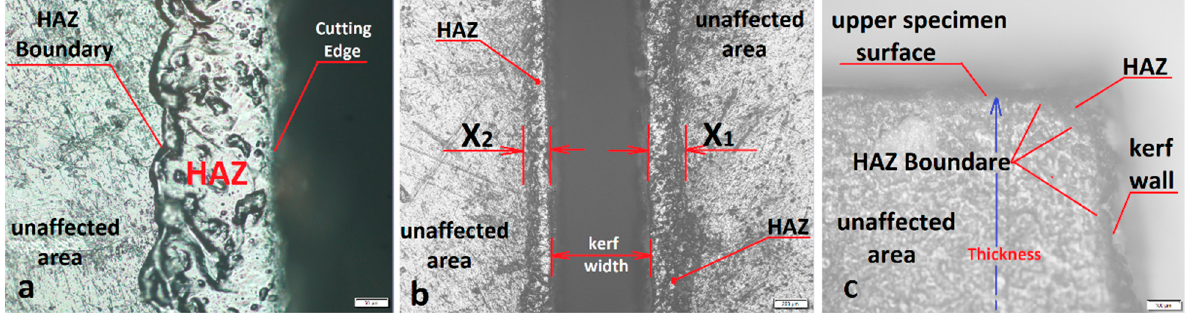
Figure 2. HAZ microscopic image. ( a ) HAZ boundary. ( b ) HAZ measurement method. ( c ) Optical image of the cross-section of the cut edge.